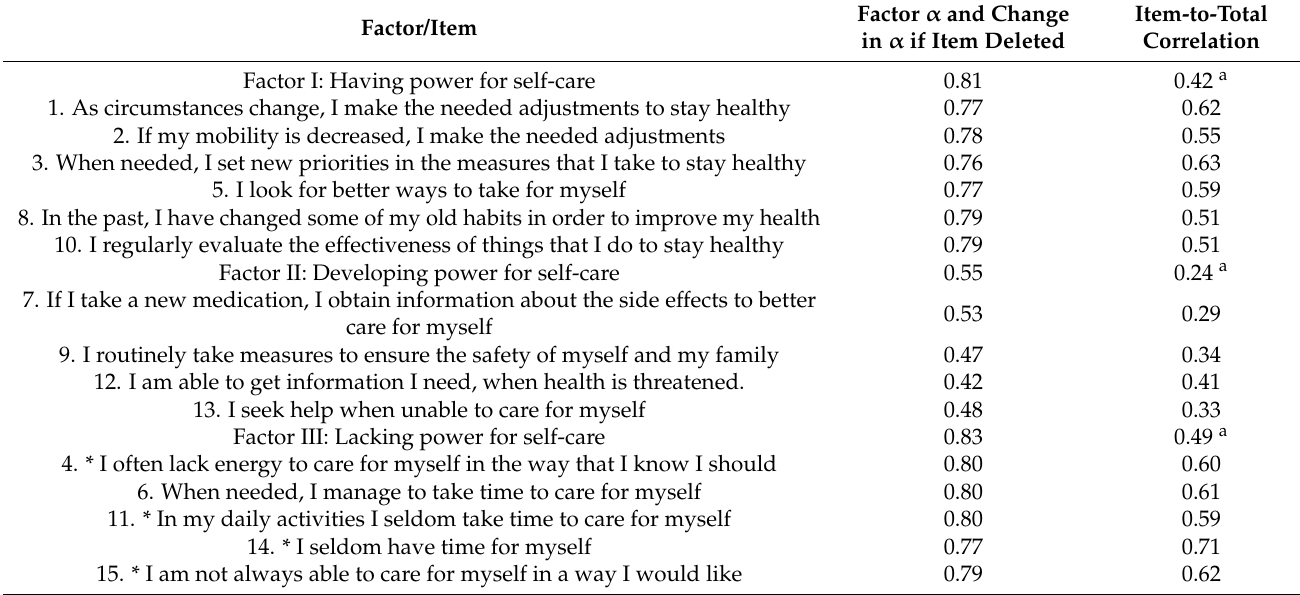
Table 5. Internal consistency of the adapted ASAS-R to Portuguese language ( n = 781). Factor/Item